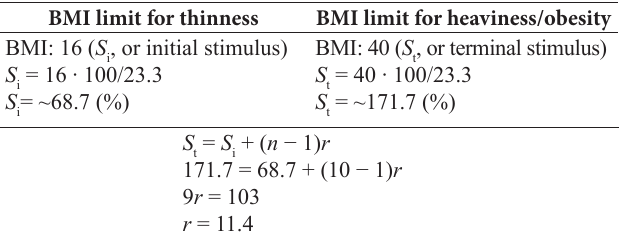
Table 1. Example of the calculation of a geometric progression of a limited scale of image sizes for a participant (BMI = 23.3). BMI limit for thinness BMI limit for heaviness/obesity